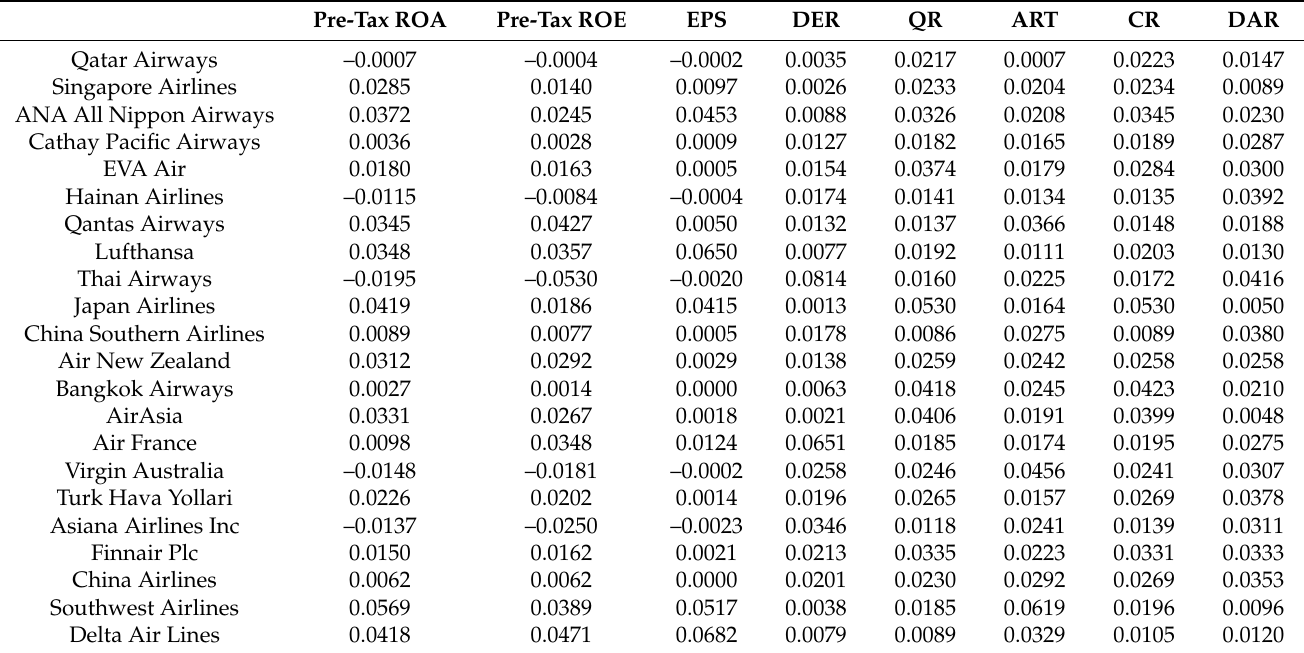
Table 5. Weighted normalized data matrix (for 2018).